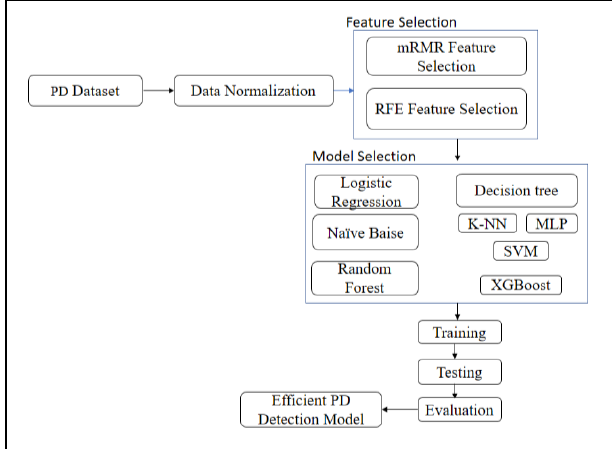
Figure 1. Overview of the proposed framework The details of the components of the proposed framework have been explained below